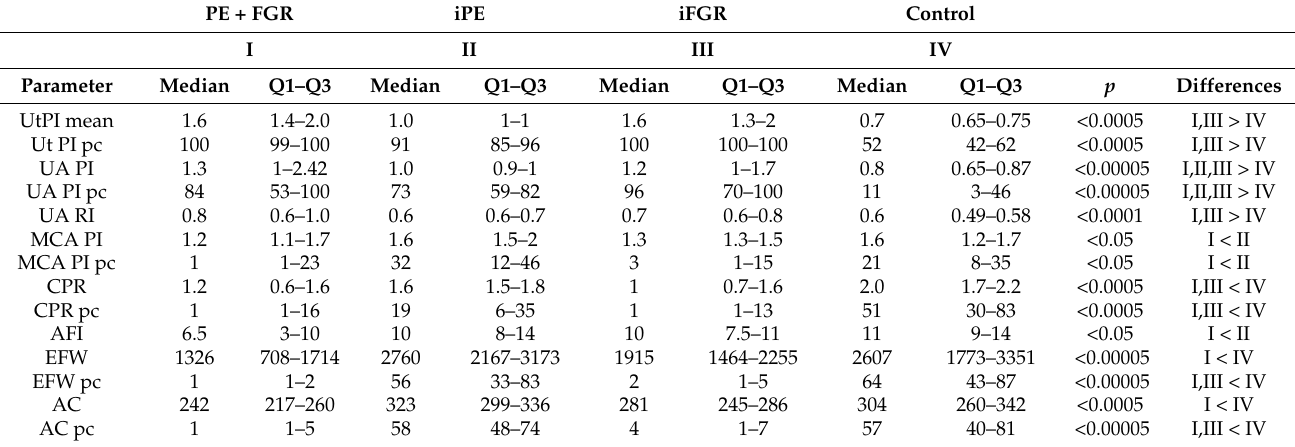
Table 3. Characteristics and statistical analysis of ultrasound, including Doppler parameters, in the study groups (based on results of the Kruskal-Wallis test and analysis of variance ANOVA with a post hoc RIR Tukey test).